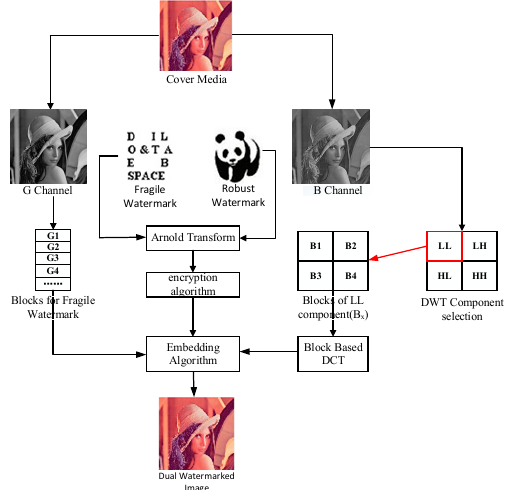
Figure 1. Framework of the original scheme.